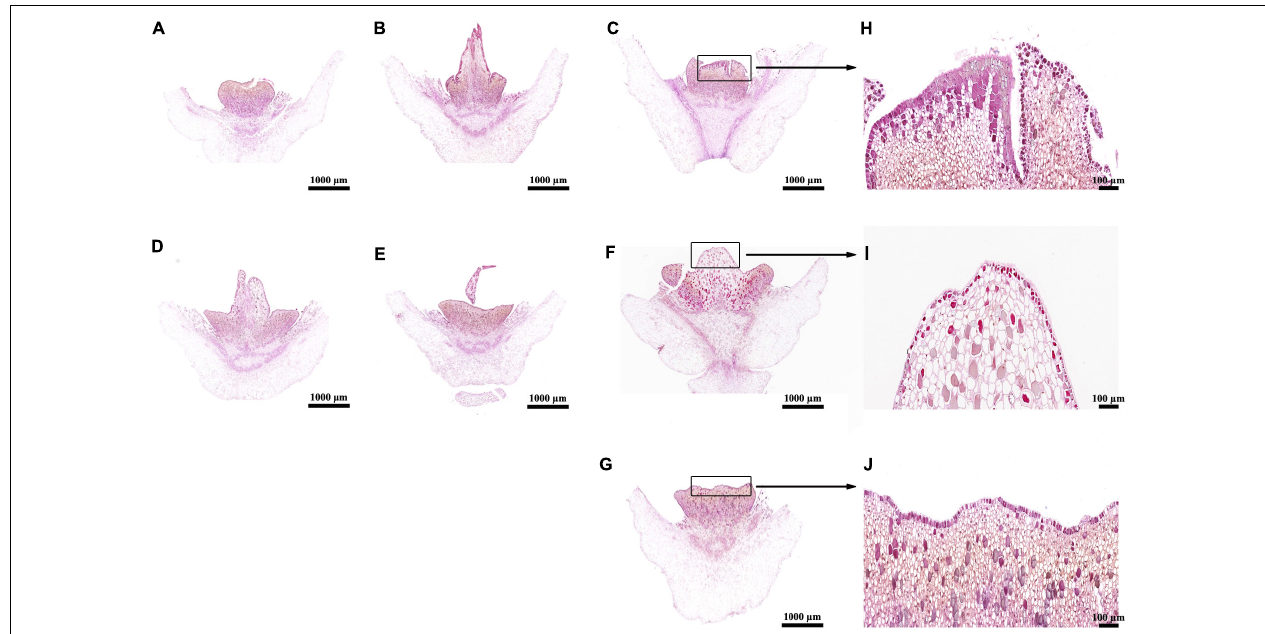
FIGURE 1 | Histological analyses of aborted pistils in ethrel- and ZT-treated androecious persimmon flowers. (A–G) Samples treated with ethrel at 100, 500, and 1,000 mg/L; ZT at 1, 5, and 10 mg/L; and control (untreated). (H) Magnified image of the aborted pistil highlighted in (C) . (I) Magnified image of the aborted pistil highlighted in (F) . (J) Magnified image of the aborted pistil highlighted in (G)